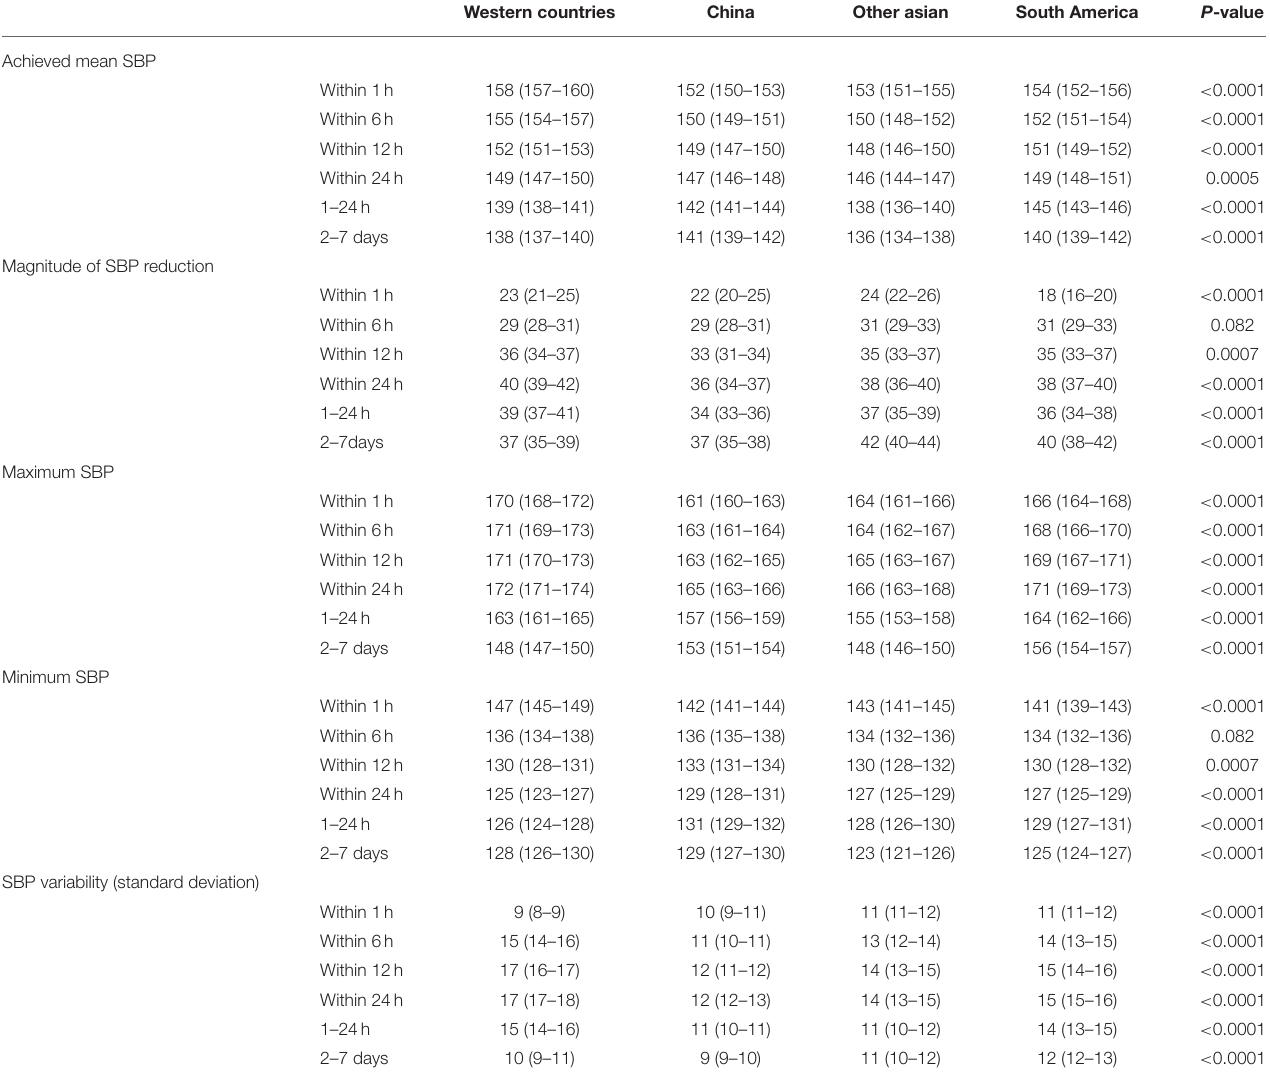
TABLE 3 | BP control by region in